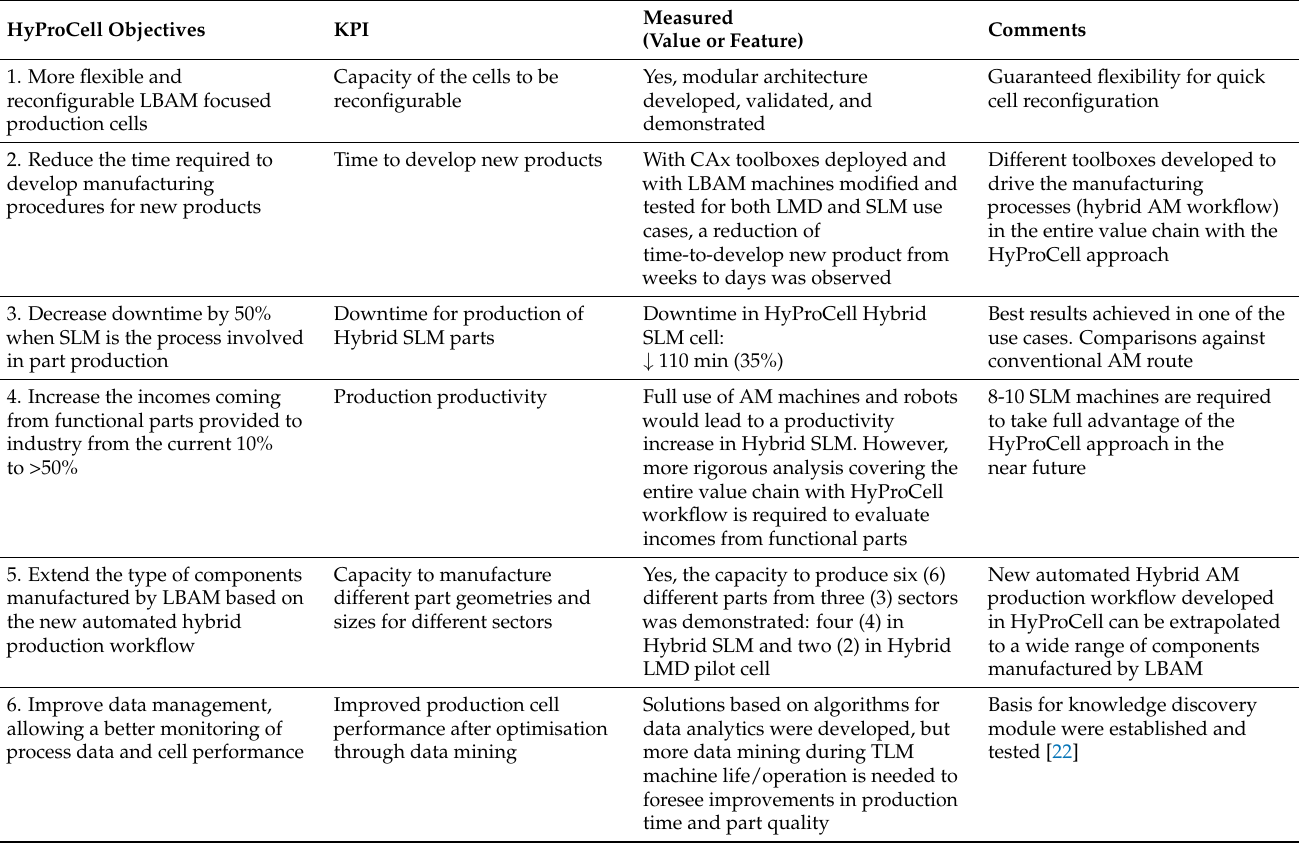
Table 1. Main outputs of HyProCell for each KPI related to the main objectives defined in the project. HyProCell Objectives KPI